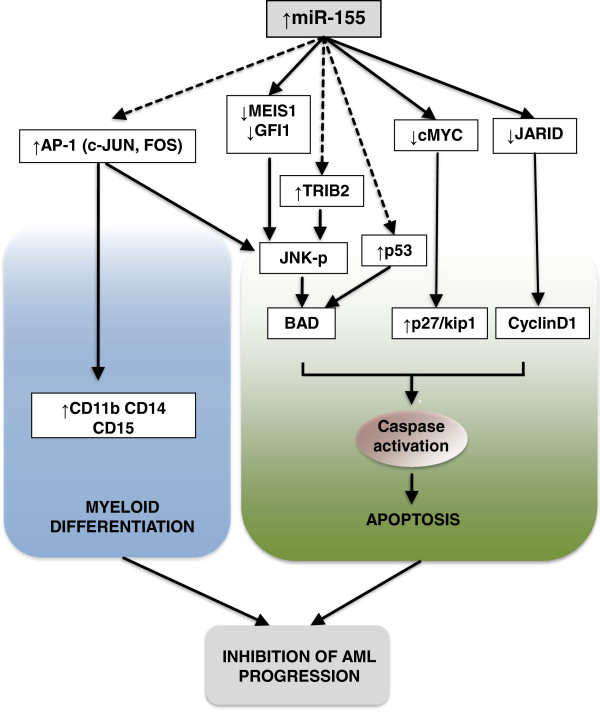
Potential regulatory mechanisms of miR-155 in AML. Model of miR-155-mediated gene regulation in FLT3-WT AML, where its expression acts to induce myeloid differentiation and caspase-3 dependent apoptosis. In AML cells miR-155 overexpression was found to decrease the expression of cMYC and MEIS1/GFI1, potentially leading to the phosphorylation of JNK and/or the activation of p27/kip1 and activation of the apoptosis cascade. The increase in AP-1 and TRIB2 genes may be caused by an intermediary, such as JARID2 inhibition, and may have functions in regulating AML cell differentiation and apoptosis.